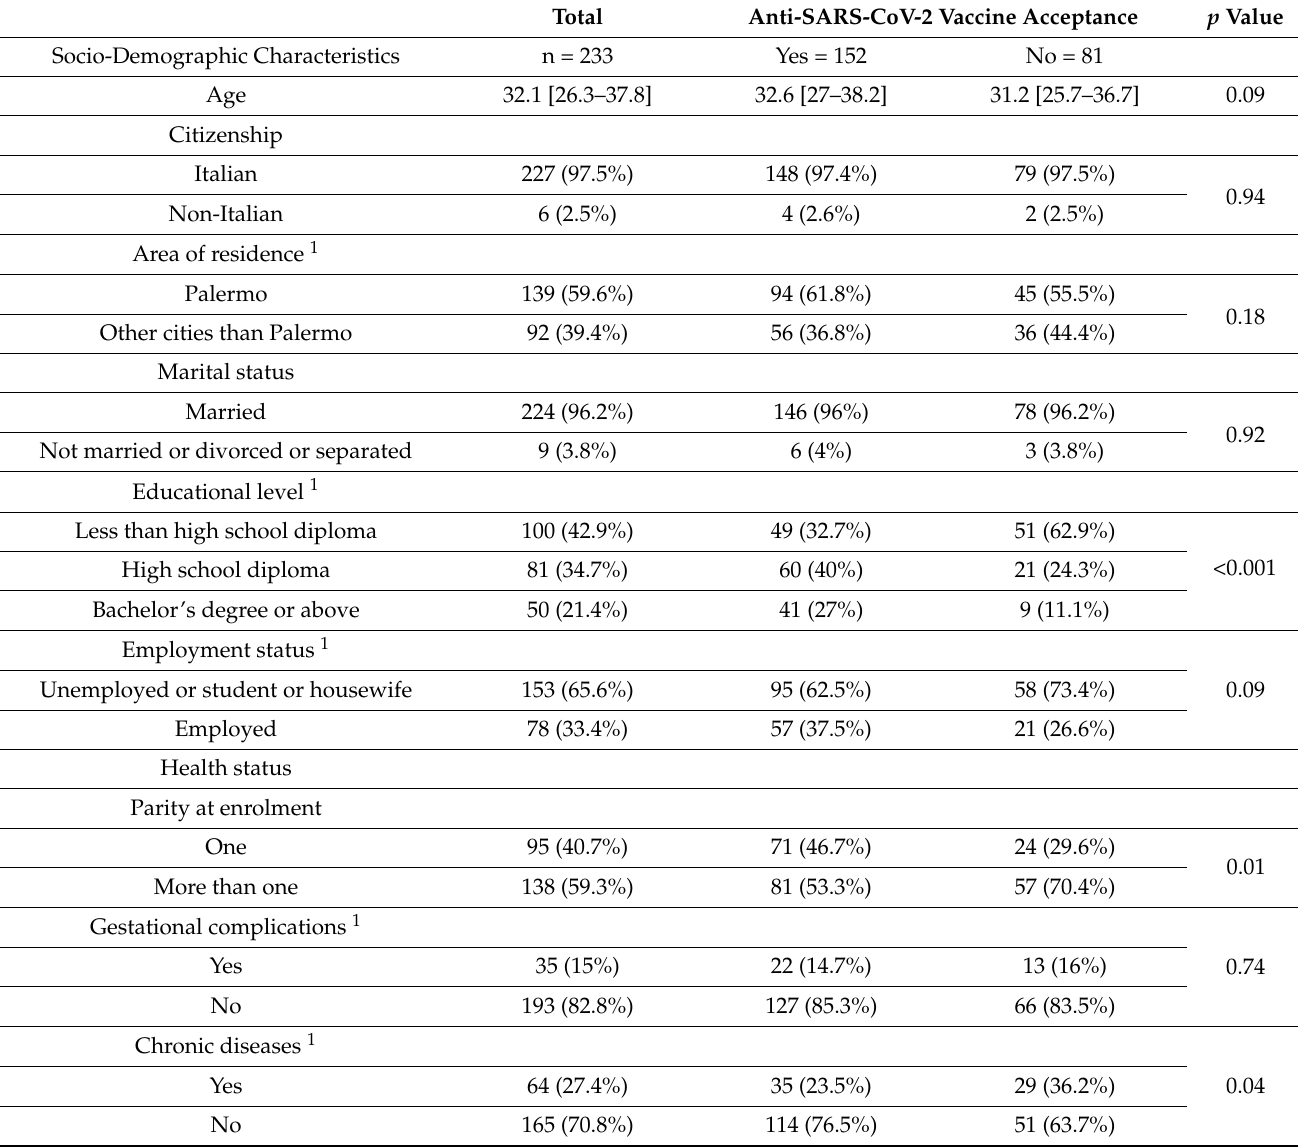
Table 1. Socio-demographic characteristics and health statuses of pregnant women enrolled in the study about anti-SARS-CoV-2 vaccine